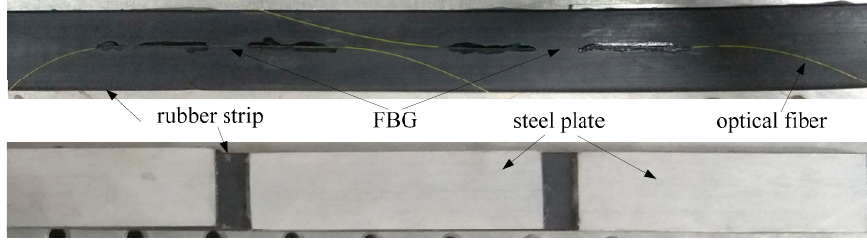
Figure 2. The photo of the FBG strain sensor.